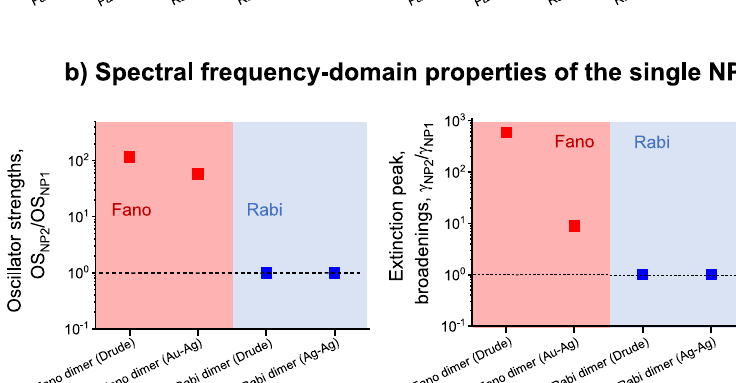
Figure 4: Summary with several kinetic parameters, for the Fano (red) and Rabi (blue) regimes, for all the dimers presented in this study (schematically shown in the upper row). (a) Temporal properties of the dimer ’ s numbers of beats (left panel), and of the decay-time ratios of isolated NPs (right panel). (b) Ratios of properties of single isolated NPs in the frequency domain, for the oscillator strength (top-left panel),theplasmonextinctionbroadenings (top-right panel) and the extinction maxima (bottom